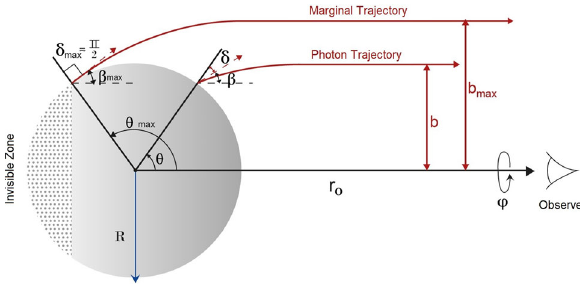
Fig. 1 A photon’s trajectory, with impact parameter b , from the stellar surface at R to the observer at r O . The deflection angle β is calculated as θ −